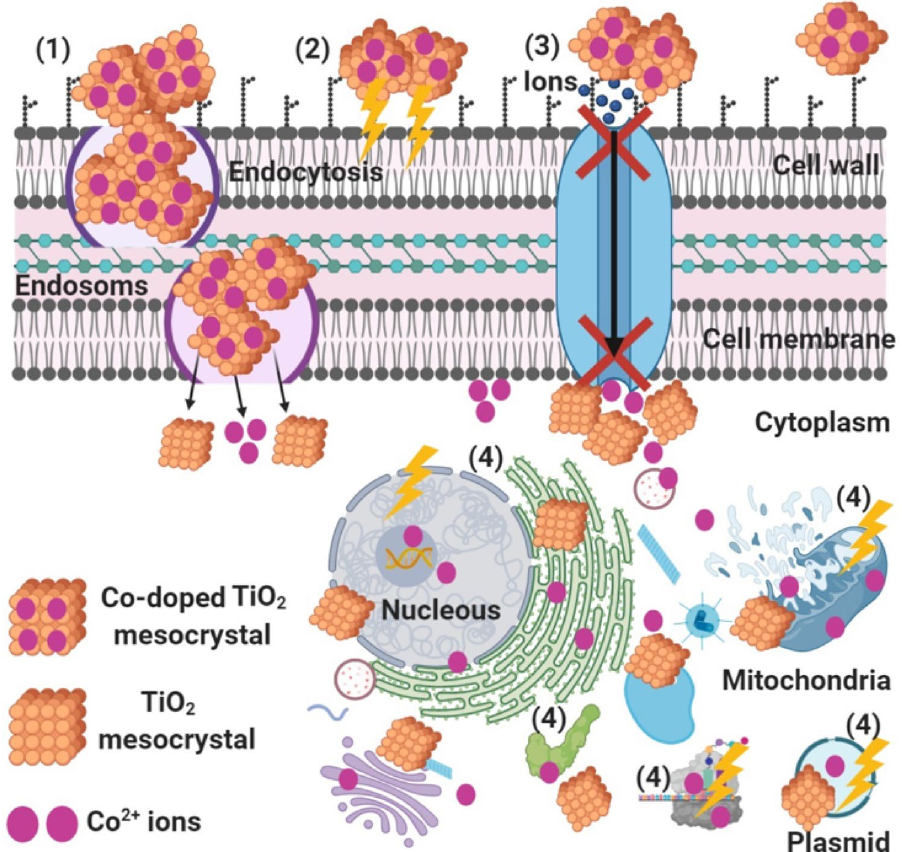
Figure 8. Schematic representation regarding the four prominent ways of antimicrobial potential of Co-doped TiO 2 mesocrystals, where (1) Co-doped TiO 2 mesocrystals adhere to the bacterial cell surface and results in membrane damage and altered transport activity; (2) Co-doped TiO 2 mesocrystals create and increase the ROS leading to cell damage, (3) Co-doped TiO 2 mesocrystals block the ions transport from and to the bacterial cell, and (4) Co-doped TiO 2 mesocrystals penetrate inside the bacterial cells and interact with cellular organelles and biomolecules, and thereby, affect respective cellular machinery, and modulate the cellular signal system and causing cell death. Co-doped TiO 2 mesocrystals may serve as a vehicle to effectively-deliver Co ions to the bacterial cytoplasm and membrane, where proton motive force would decrease the pH to be less than 3.0 and therefore improve the release of Co